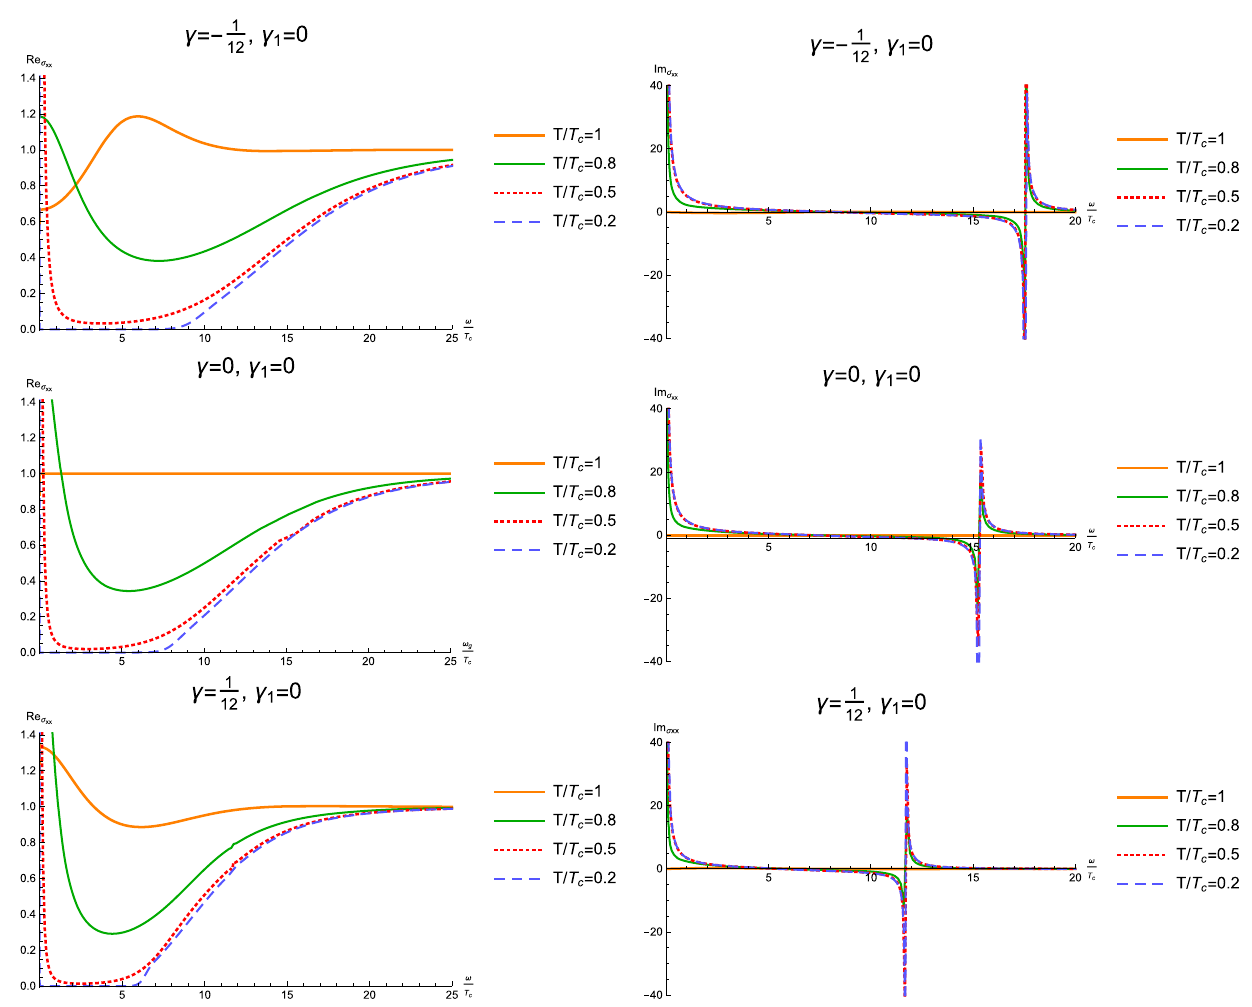
Fig. 4 The conductivities σ xx as a function of the frequency for different γ . The left panels are for the real part and the right panels are for the imaginary